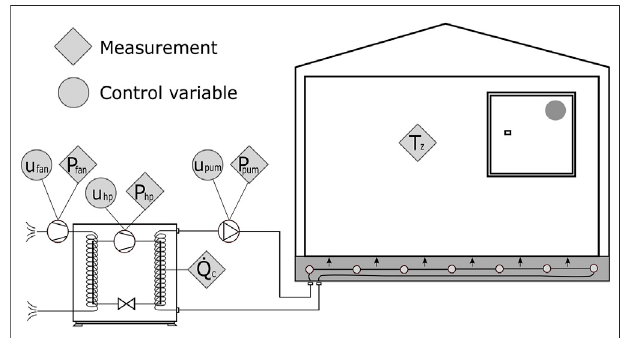
FIGURE 3 | Scheme of the BESTEST Hydronic Heat Pump building